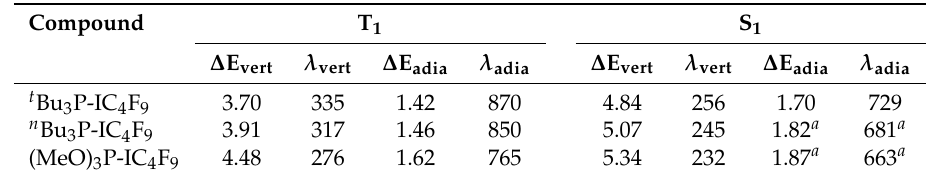
Figure 7. Nuclear arrangement of the phosphine–IC 4 F 9 adducts at the optimized T 1 minima. Table 2. Vertical and adiabatic excitation energies ( ∆ E vert and ∆ E adia /eV) and corresponding transition wavelengths ( λ vert and λ adia /nm) including SOC at the DFT/multireference spin–orbit configuration interaction (MRSOCI) level of theory. Triplet energies have been averaged over the three states with largest T 1